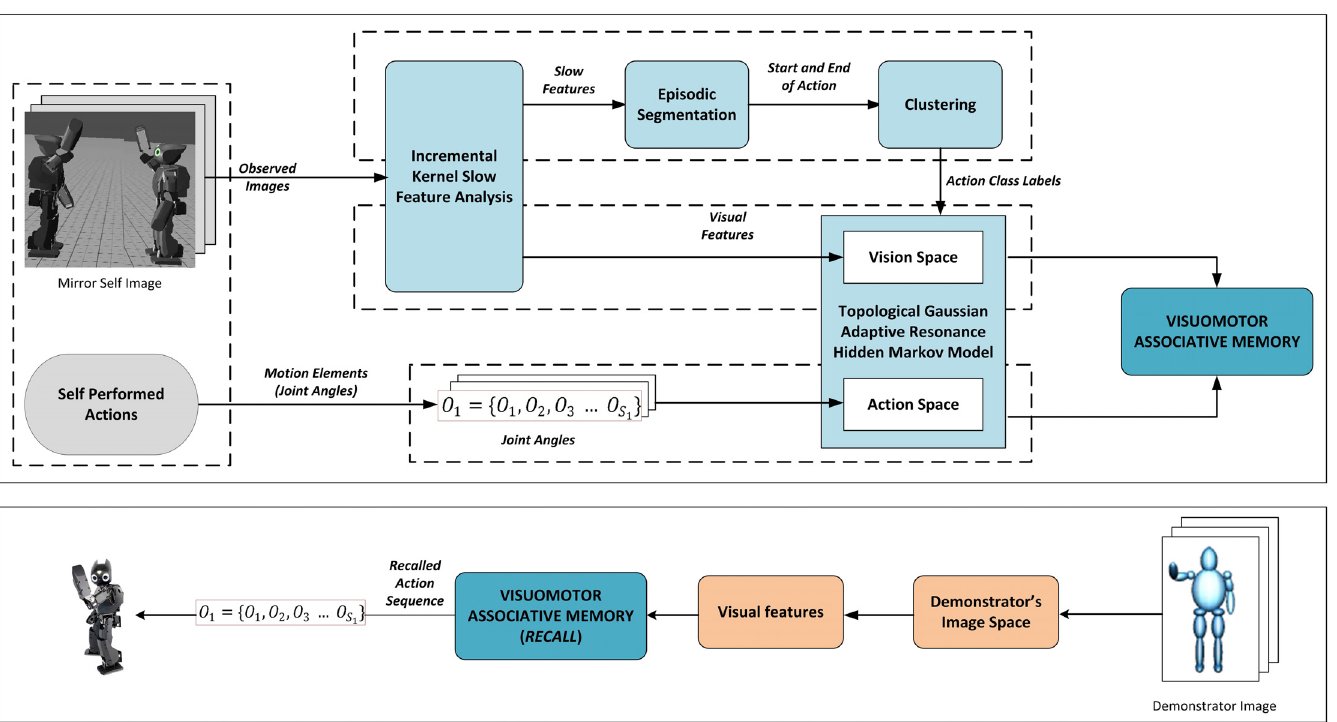
Fig 3. Architecture for incremental imitative learning through